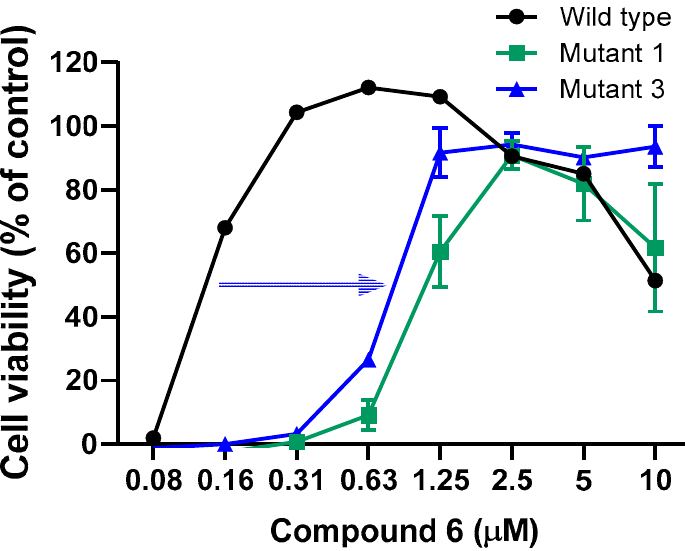
Figure 4. Phenotypical confirmation of compound 6 res MNV in RAW 264.7 cells. Confirmation of the compound 6 res MNV variants, which were independently selected after 30 passages (6 months). Results are mean values ( ± SEM) of 3 independent experiments.